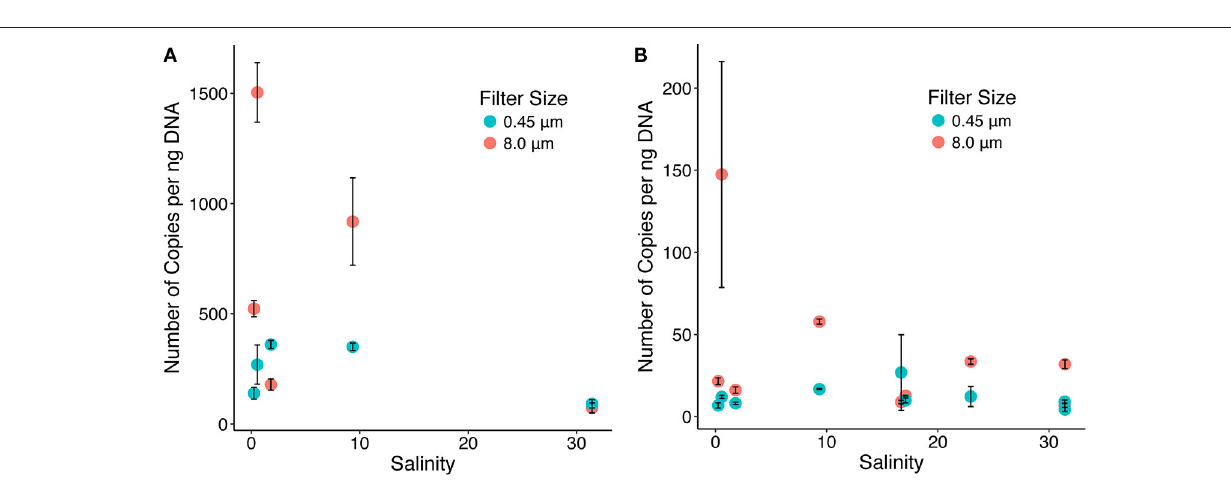
FIGURE 4 | mcrA (A) and MGC archaea (B) copy numbers for small (blue) and large (red) size